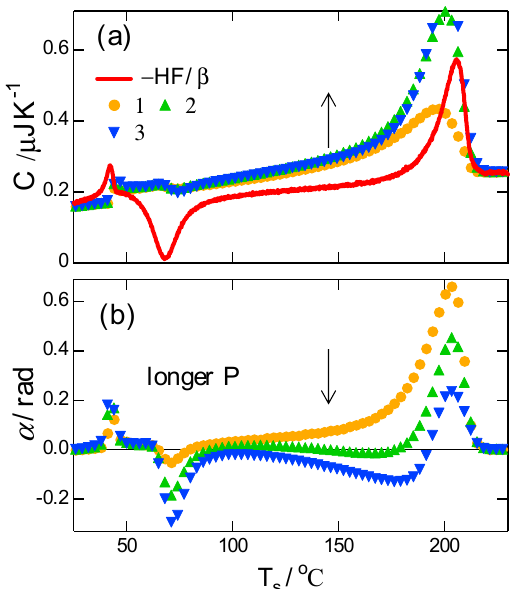
Figure 6. T-M FSC results of ( a ) magnitude and ( b ) phase angle during heating after quench- ing and annealing at T a = 25 ◦ C for 10 s. β = ∆ T 0 / P = 100 K s − 1 with ( ∆ T 0 / P ) /K s − 1 = 1 : 3/0.03, 2 : 6/0.06, 3 : 9/0.09. Solid line in ( a ) represents − HF/ β